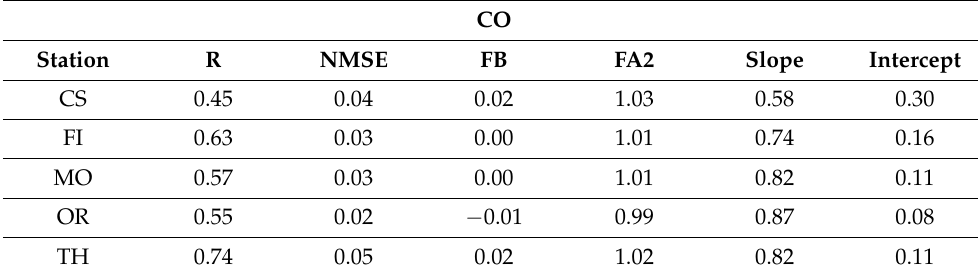
Table 6. Scatter plot of modelled vs measured PM2.5/PM10 for the stations (FI, MO, OR, TH) with CO and without CO (no CO) as input neuron. In both cases, the meteorological parameters used as input were the same (T, RH,